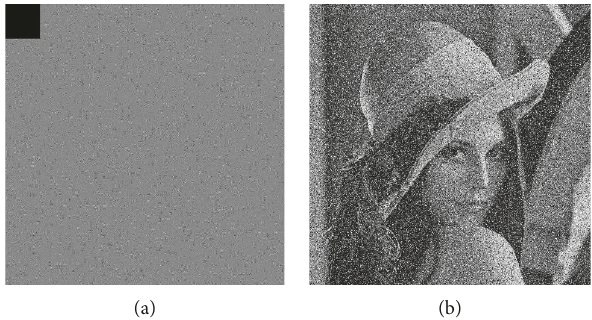
Figure 12: Results of attacks with cropping attack. (a) Encrypted image with (64 × 64) cropping size. (b) Decrypted